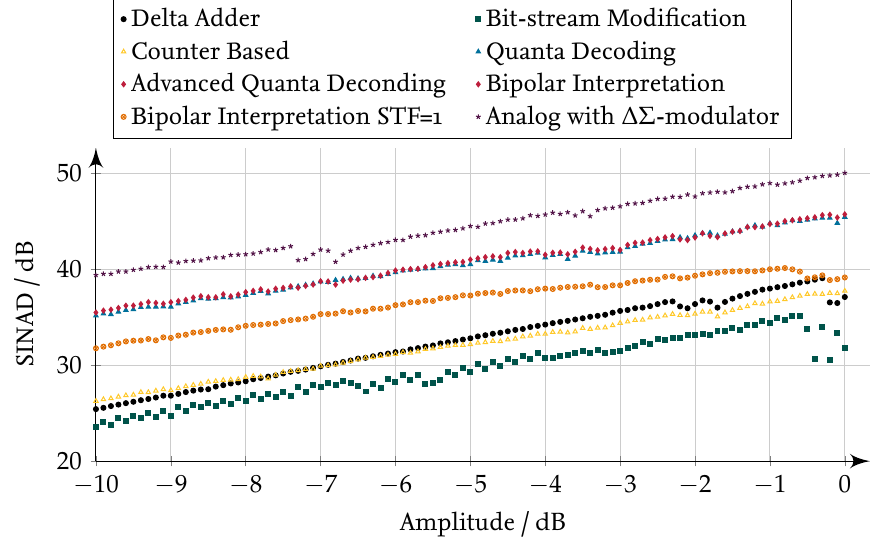
Figure 18. Resulting SINAD after the linear operation add with different ∆Σ SP implementations for a sine wave excitation with different